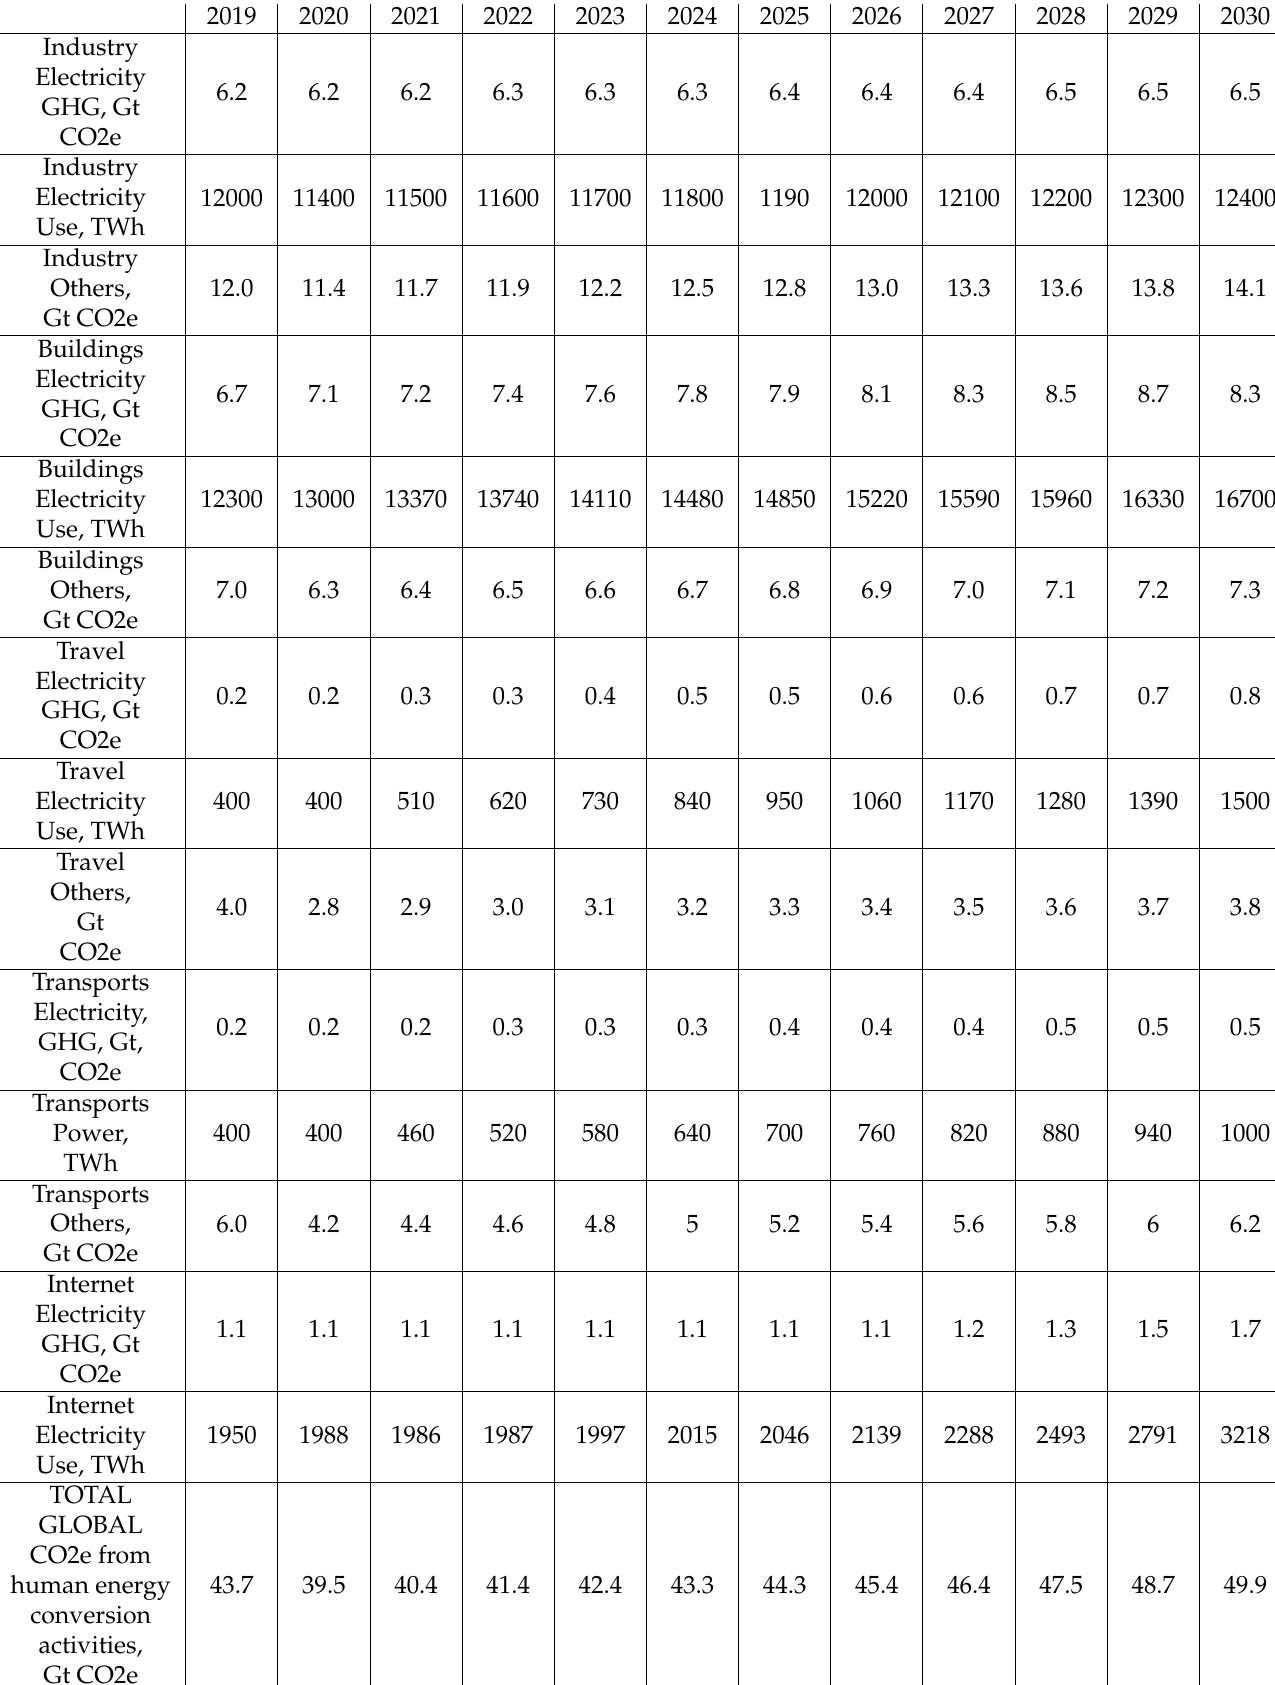
Table 3. Division of GHG supply between electricity and other sources between 2020 and